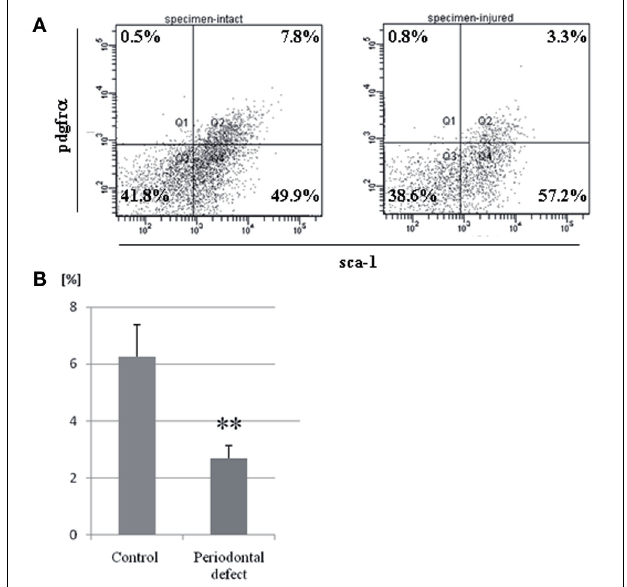
FIGURE 5 | Postoperative changes in MSC population in bone marrow. BMCs were collected from murine femurs and tibias in both the control and experimental groups. (A) A representative data from FACS analyses. (B) FACS analysis showed that the percentage of MSCs in bone marrow of mice with periodontal defects was significantly lower than in controls. ( ∗∗ p = 0 . 01) Independent experiments were repeated at least five times.